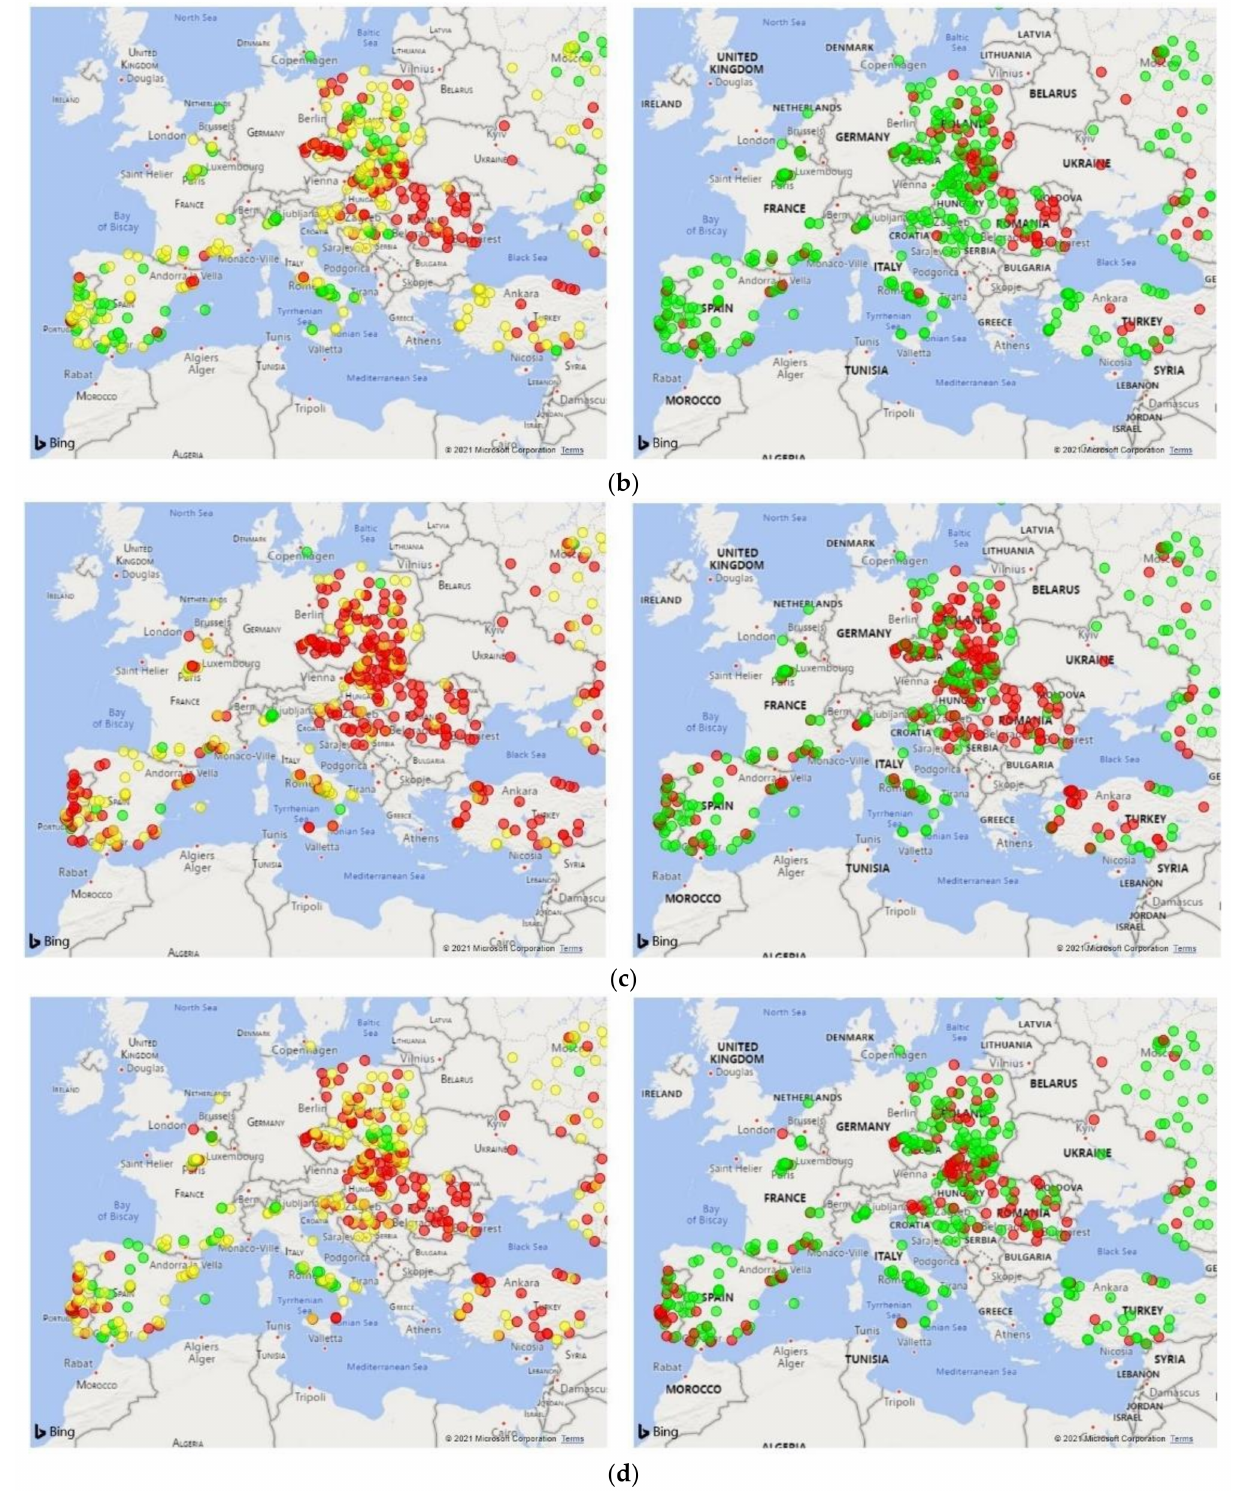
Figure 5. COVID-19 outbreak risk mapping in European clinics of the Nephrocare network. Geographical risk maps were built considering epidemic data related to the following exemplary dates: ( a ) 2 August 2020, ( b ) 4 October 2020, ( c ) 1 November 2020, and ( d ) 3 January 2020. Panels on the left show clinic clusters according to the risk of a COVID-19 outbreak occurrence within 2 weeks: Red circles: risk > 12.5%; Yellow, 1.5% < risk ≤ 12.5%; Green, risk ≤ 1.5%. Panels on the right report the actual incidence of COVID-19 outbreaks in the forecasting